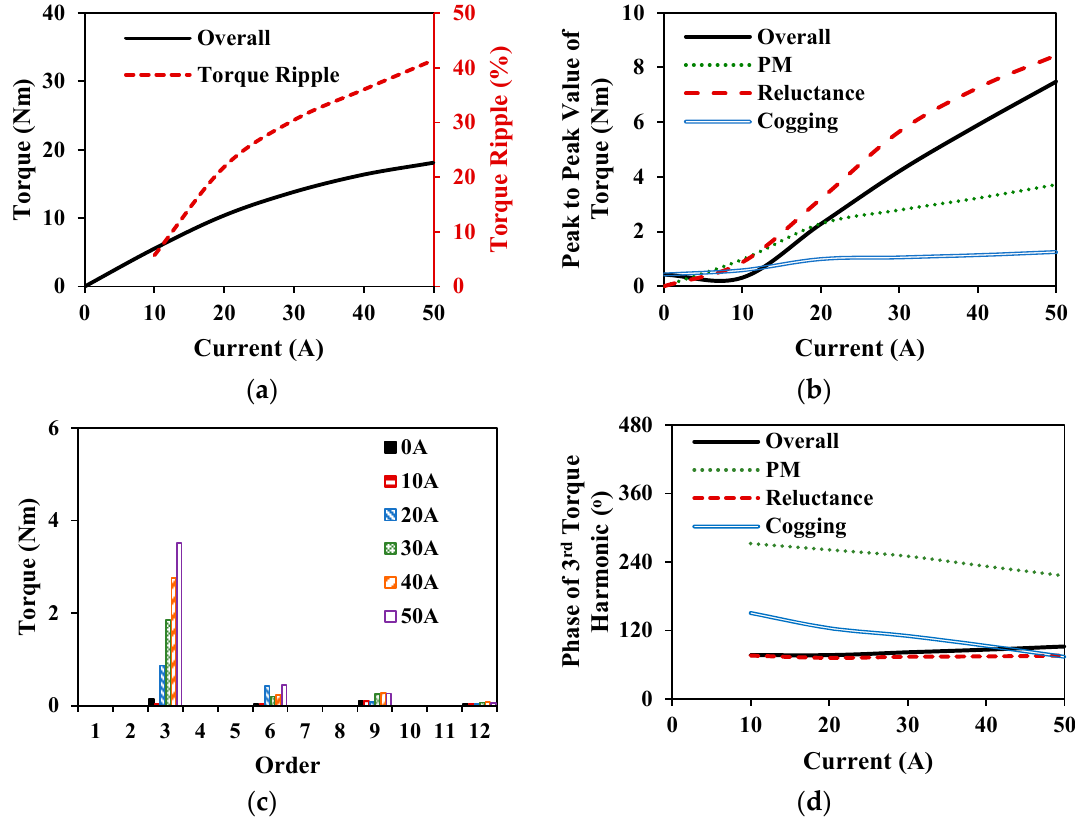
Figure 33. Torque characteristics of 12s8p-PSCPPM machine. ( a ) Average torque and torque ripple. ( b ) Peak to peak value of torque components. ( c ) Overall torque ripple spectra. ( d ) Phases of dominant 3rd order torque harmonics.